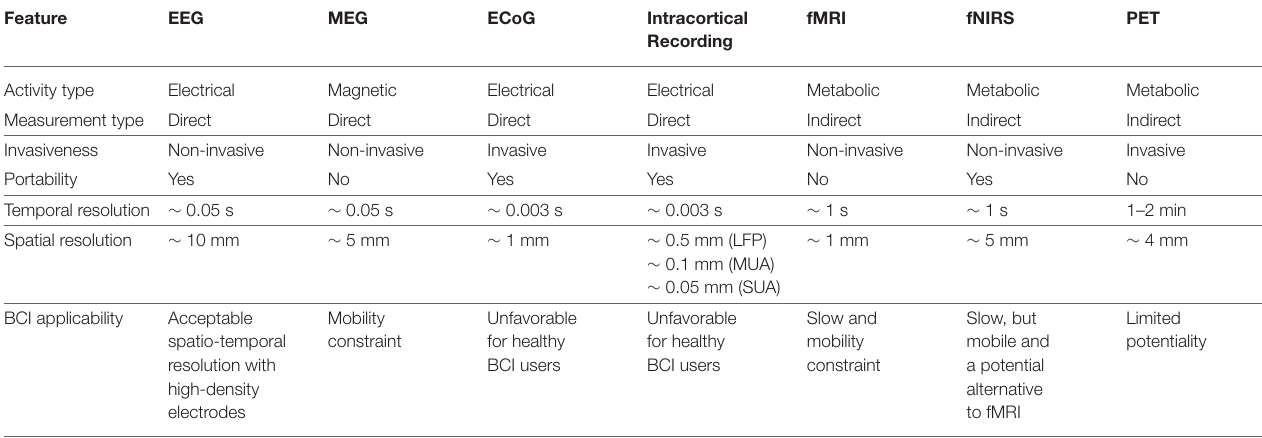
TABLE 1 | A list of neuroimaging techniques and their suitability in brain computer interface (BCI) applications.